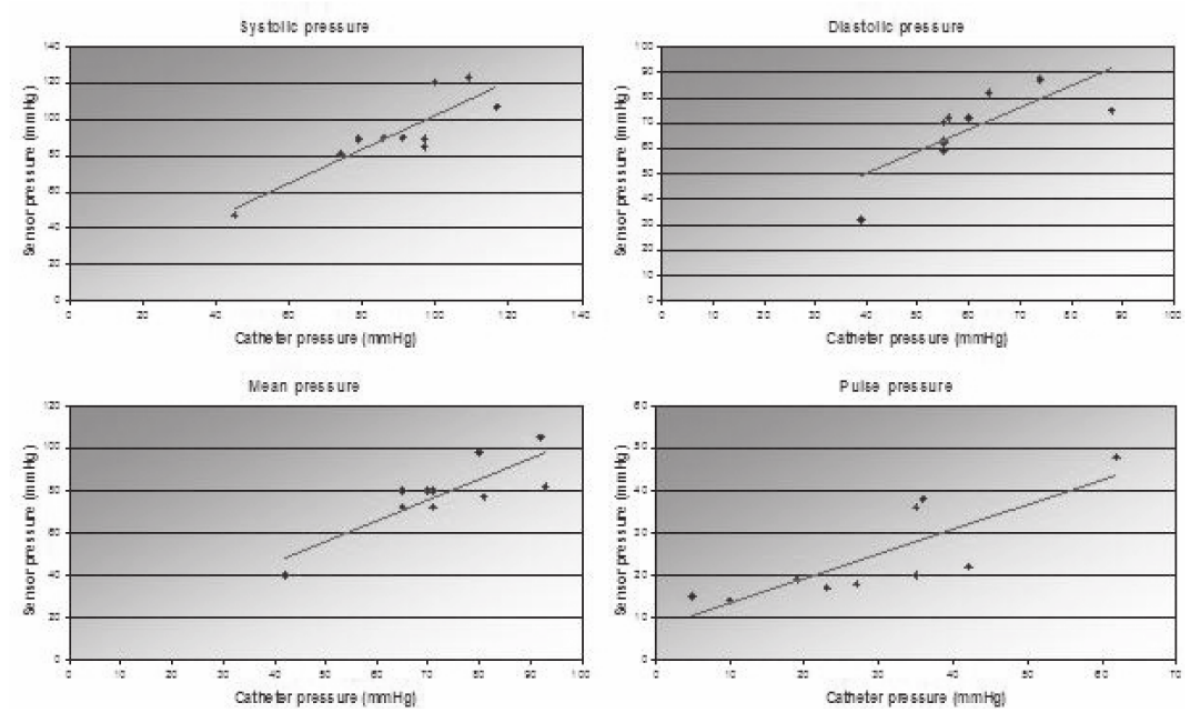
Figure 6 – Scatterplots showing agreement between the Reading 2 pressure measurements of angiographic catheter and pressure sensor.